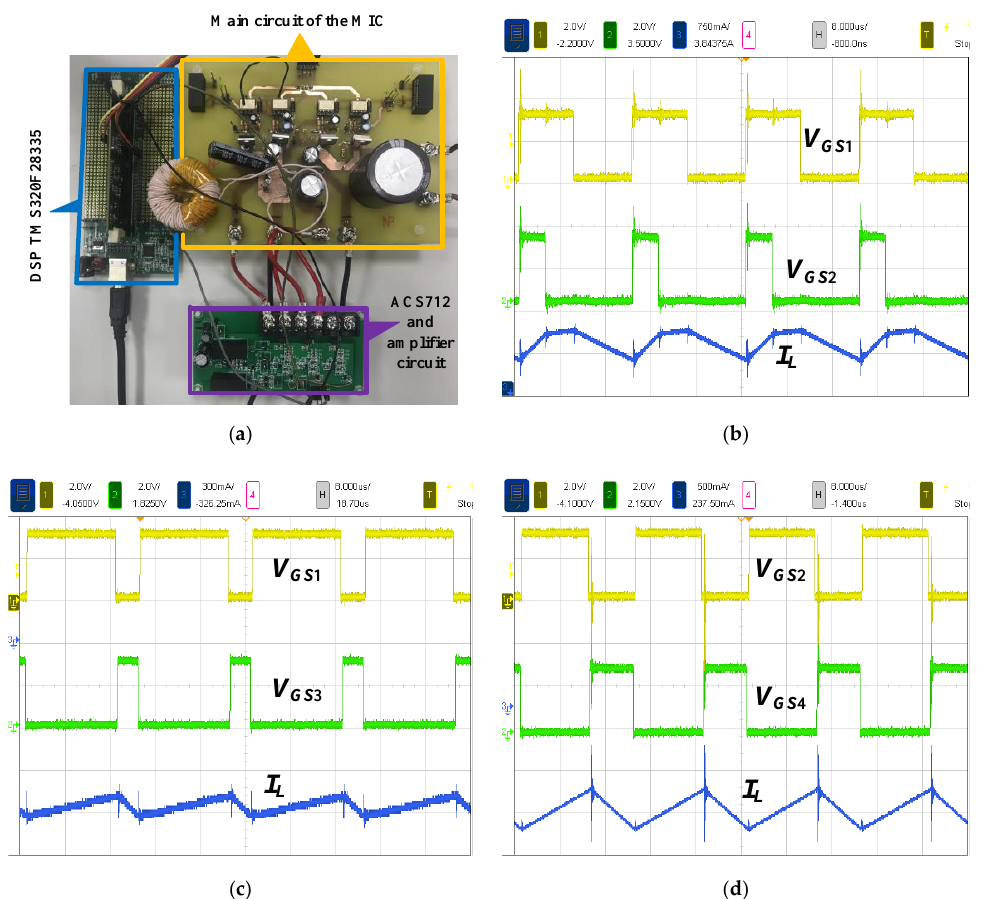
Figure 12. The hardware circuit figure and experimental waveforms ( a ) The prototype circuit figure; ( b ) The gate signal and inductor current waveforms with the discharging scenario; ( c ) The gate signal and inductor current waveforms with the charging scenario A; ( d ) The gate signal and inductor current waveforms with the charging scenario B.